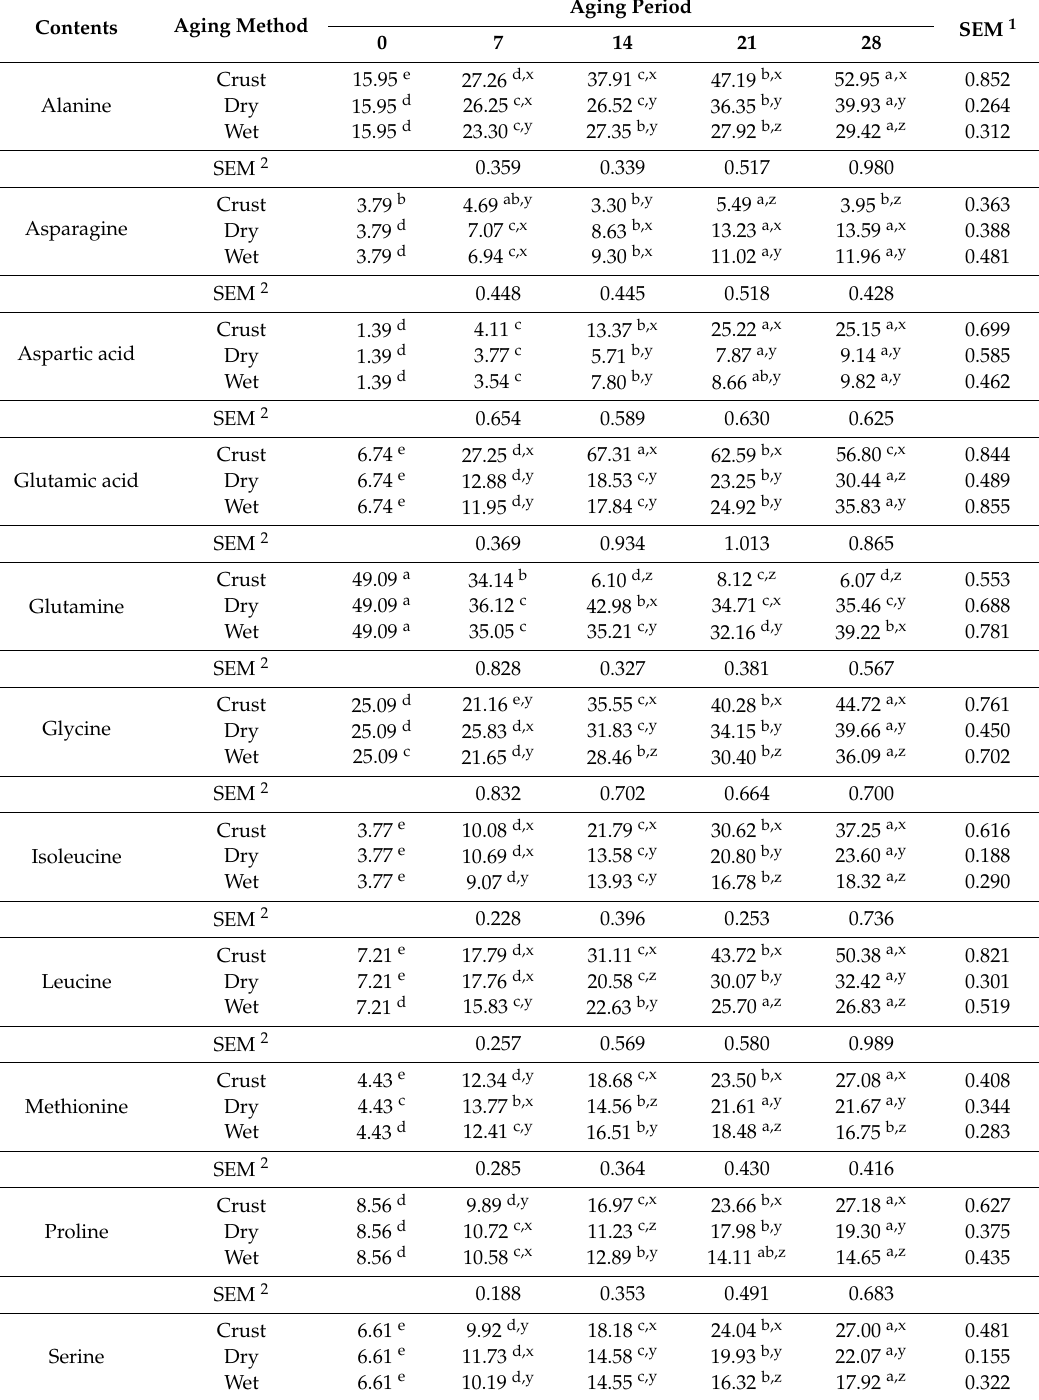
Table 1. Free amino acids contents (mg / 100 g) from di ff erent aged beef striploin ( longissimus lumborum ) using 1 H- 13 C HSQC on 850 MHz cryo-NMR